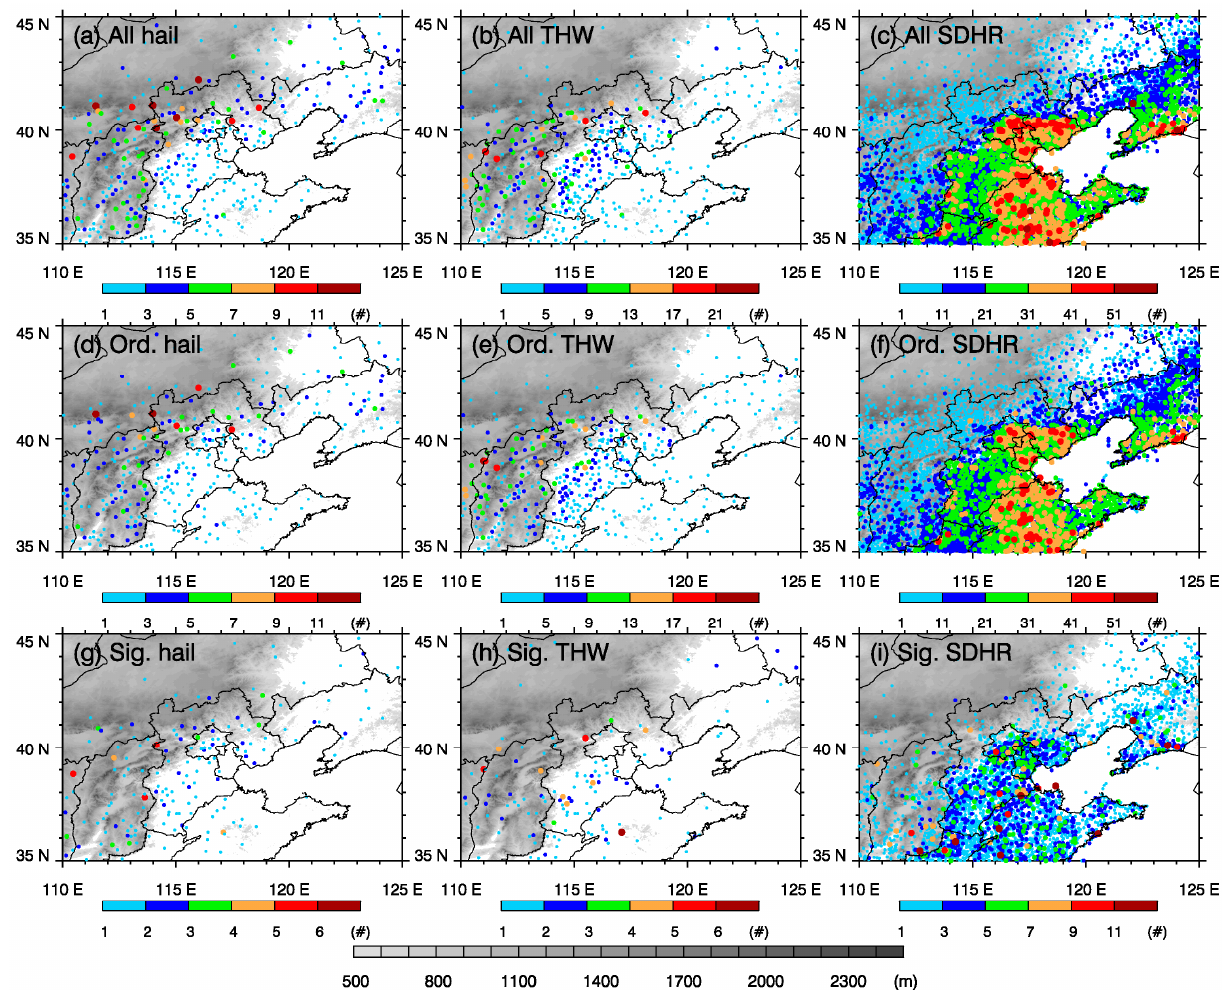
Figure 3. Spatial distribution of the occurrence frequencies of ( a – c ) all severe convective events, ( d – f ) ordinary (ord.) severe convective events, and ( g – i ) significant (sig.) severe convective events during the warm seasons of 2011–2018 over North China. Panels ( a , d , g ) represent hail events, ( b , e , h ) represent THW events, and ( c , f , i ) represent SDHR events. Gray shadings represent topography.